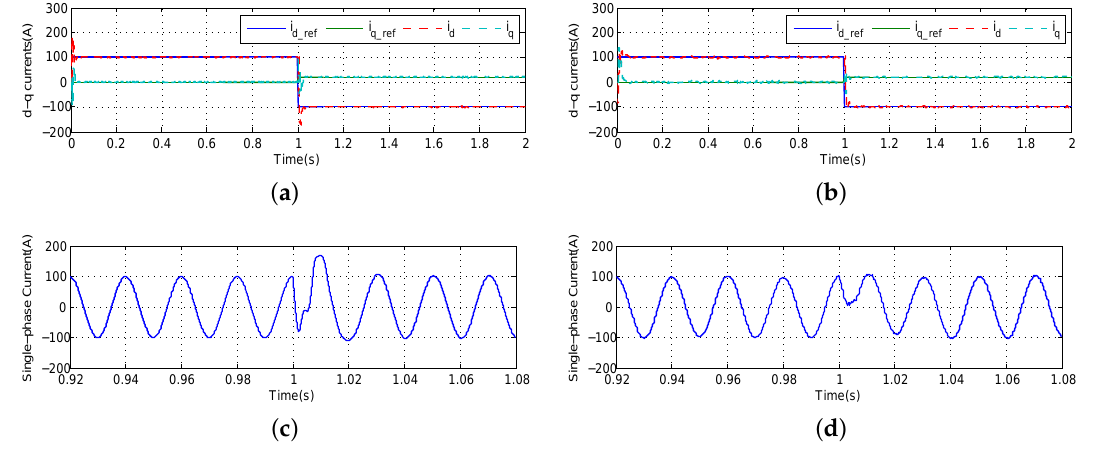
Figure 13. Comparisons for LCL filter-based GCC. ( a ) Conventional vector control: d - q currents; ( b ) NN vector control: d - q currents; ( c ) conventional vector control: single-phase current; ( d ) NN vector control: single-phase